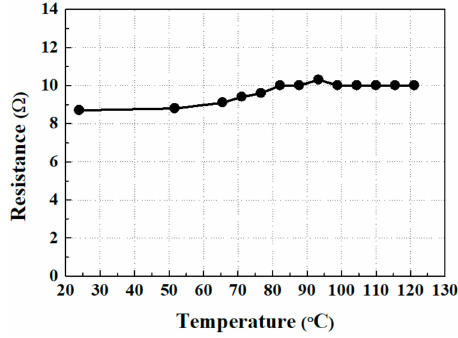
Figure 4. The electrical resistance change of the electric coil with the temperature.